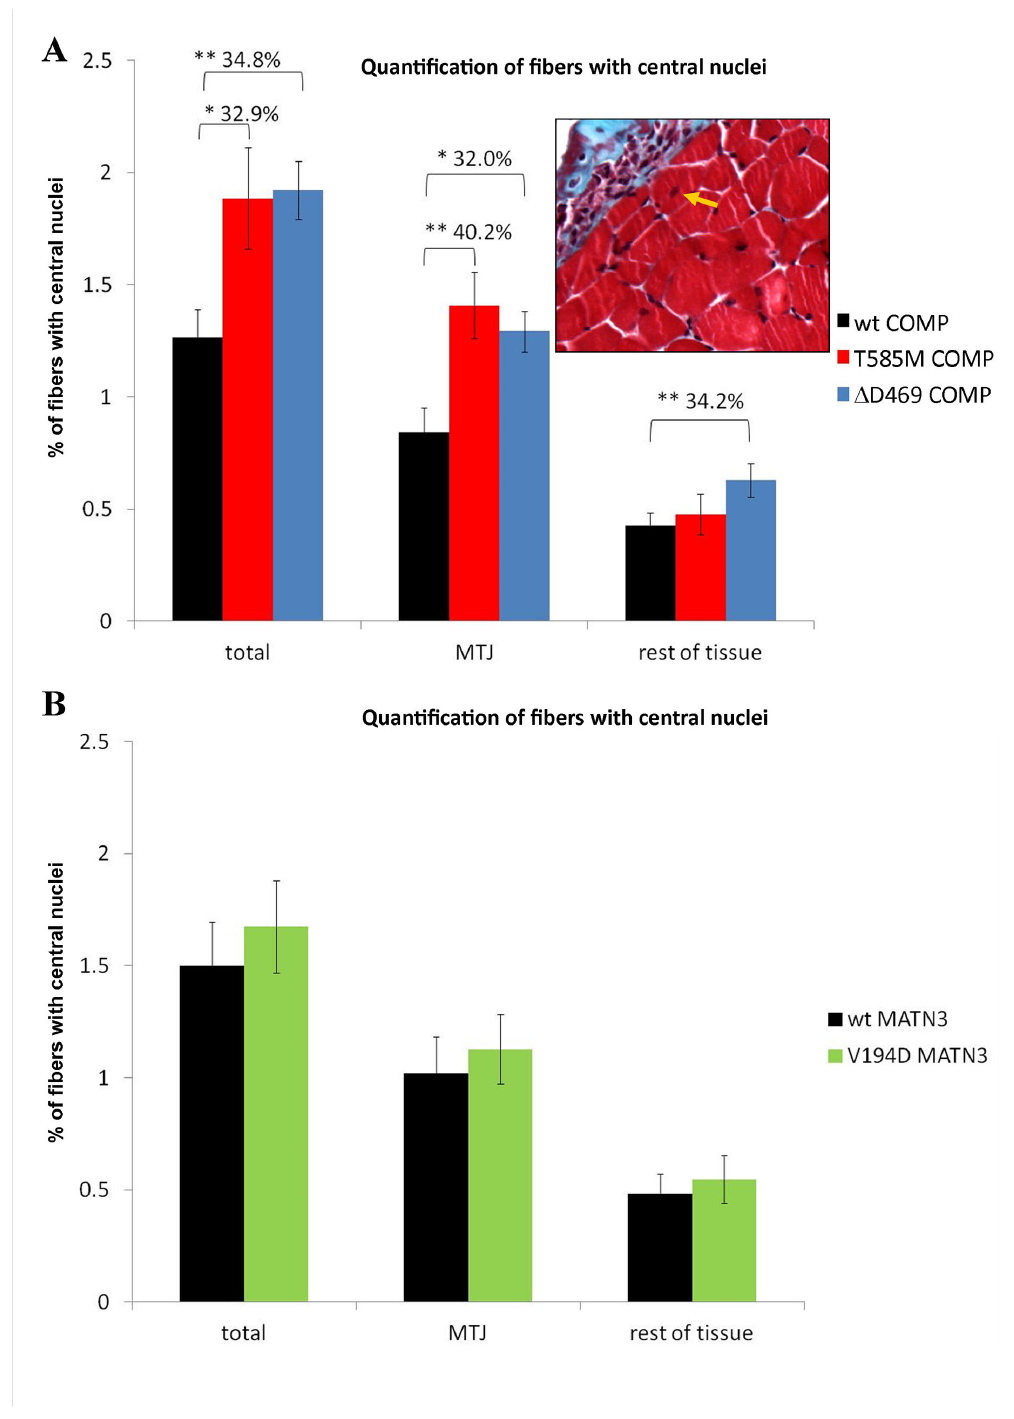
Figure 3. Quantification of the muscle fibers with central nuclei at 3 weeks of age. Quantification based on images obtained using the modified Gomori trichrome stain on transverse sections of mouse legs at 3 weeks of age. Inset shows an example of stained tissue skeletal muscle is stained red, collagenous tissue blue, nuclei black - yellow arrow indicates a muscle fibre with central nucleus. Mutant COMP mice ( A ) have more muscle fibers with central nuclei around the myotendinous and perimysial junction than their wild type littermates. Matrilin 3 mutant mice ( B ) show similar distribution of fibers with central nuclei as their wild type littermates. Error bars; SEM (standard error of the mean; n≥3). Key: * P<0.05, ** P<0.01, *** P<0.001. doi: 10.1371/journal.pone.0082412.g003 PLOS ONE |